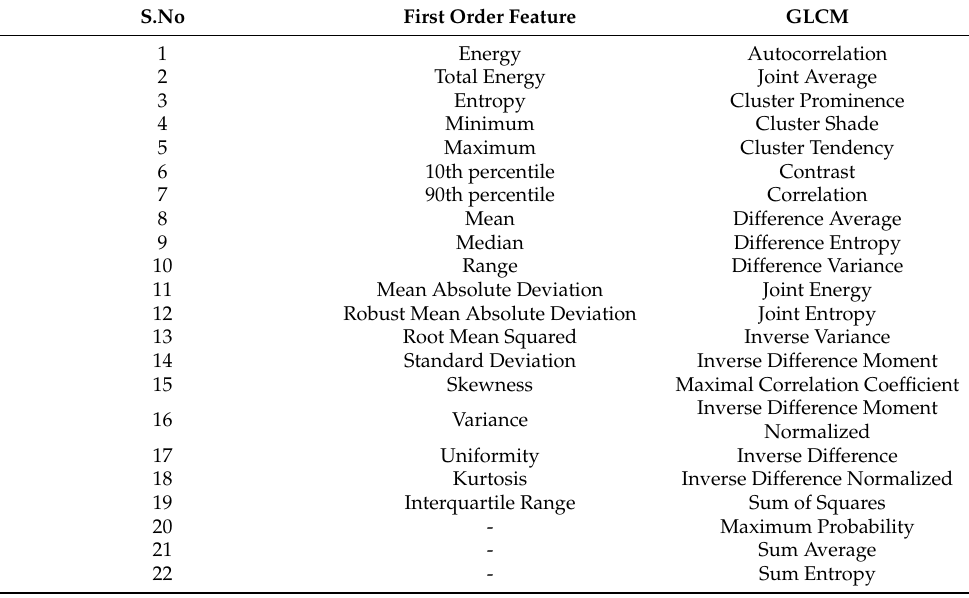
Table A1. Features Extracted from PY-Radiomics.